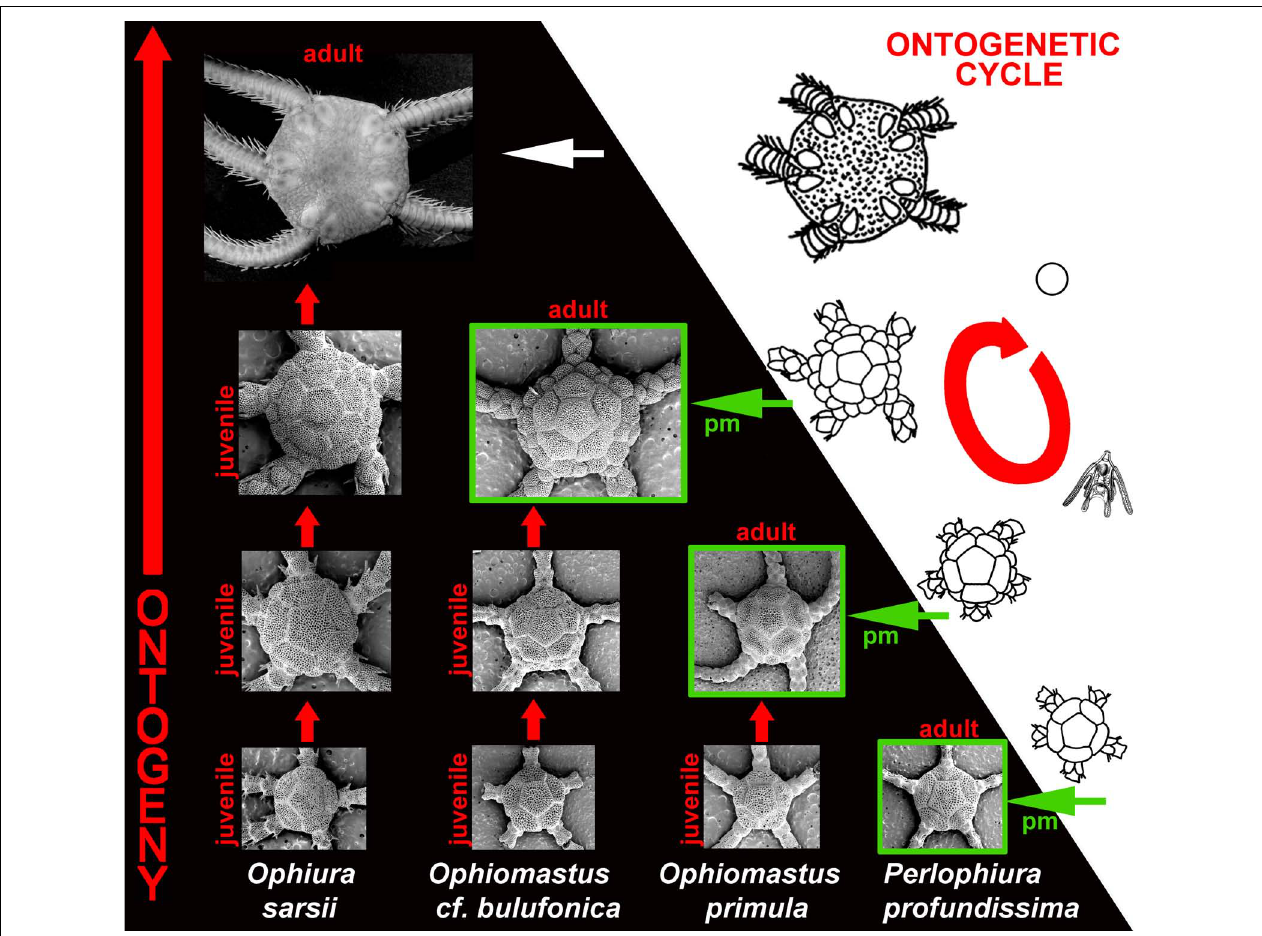
FIGURE 4 | Ontogenetic-and-evolutionary linkage through the modifications of the ontogenetic cycles of ophiuroid echinoderms. Note significant similarity between ophiuroid ontogenetic periods (hence, phylotypic periods) and adult organization of particular paedomorphic (pm) ophiuroid taxa (e.g., Ophiomastus and Perlophiura , green